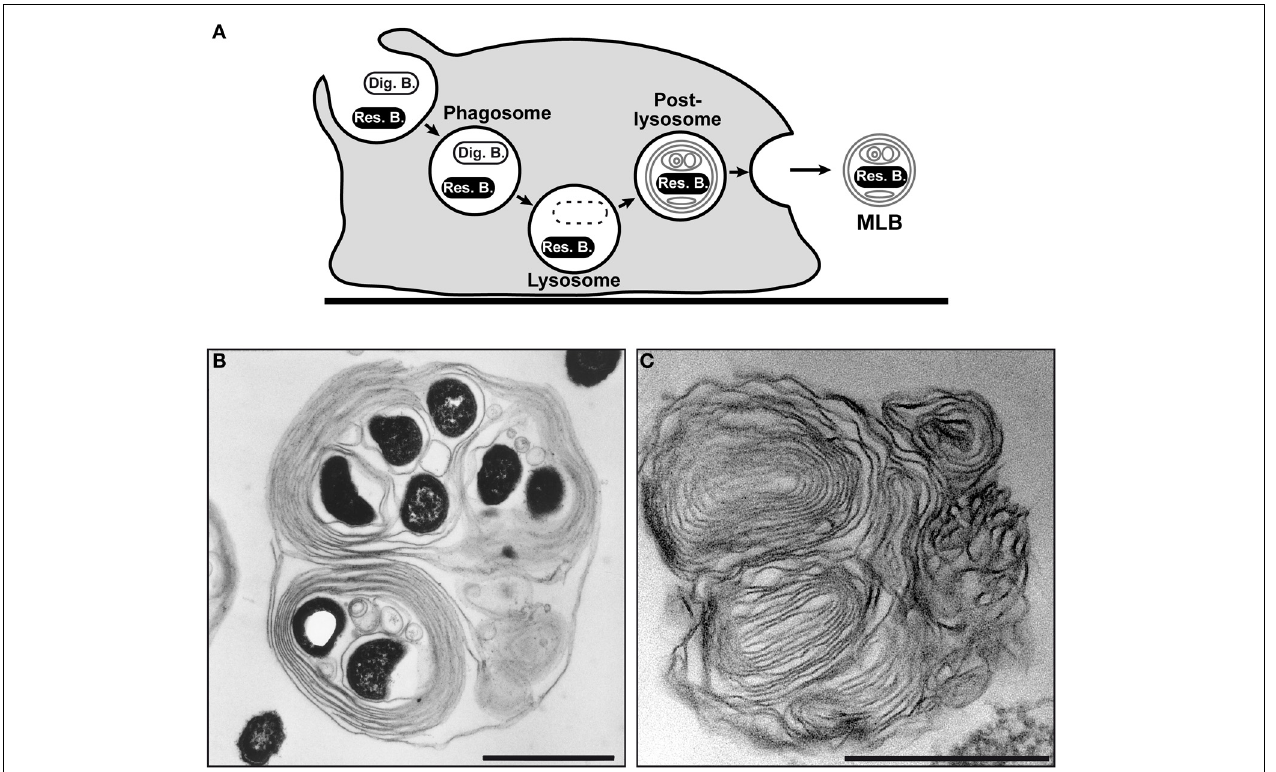
FIGURE 1 | Bacteria packaging by amoebae. (A) Schematic diagram of the packaging process that allows packaged bacteria to resist lysosomal degradation (Res. B), unlike digestible bacteria (Dig. B). The resisting bacteria are packaged in multilamellar bodies (MLB) and are then secreted by the amoebae. (B) Transmission electron microscopic image of L. pneumophila bacteria (black ovoid forms) packaged in a MLB produced and secreted by